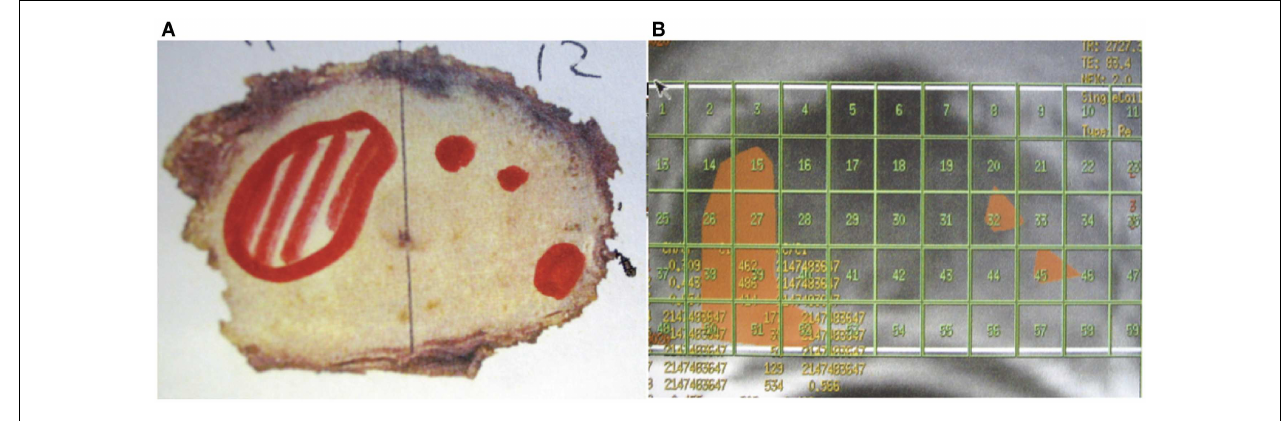
long-term rectal damage. (A) The areas outlined in red showed the cancerous tissue in the right and left lobe in the prostate. (B) The areas outlined in orange had an abnormal CCr (choline + creatine/ citrate) ratio suspicious for malignancy on pre-operative magnetic resonance spectroscopy. (Images courtesy of Dr. Shigeo Horie,Teikyo University, and Dr. John G. Delinasios, International Institute of Anticancer